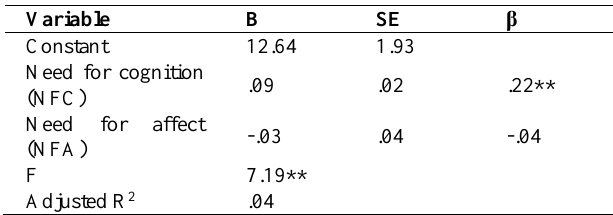
Personality traits and verbal content preference on